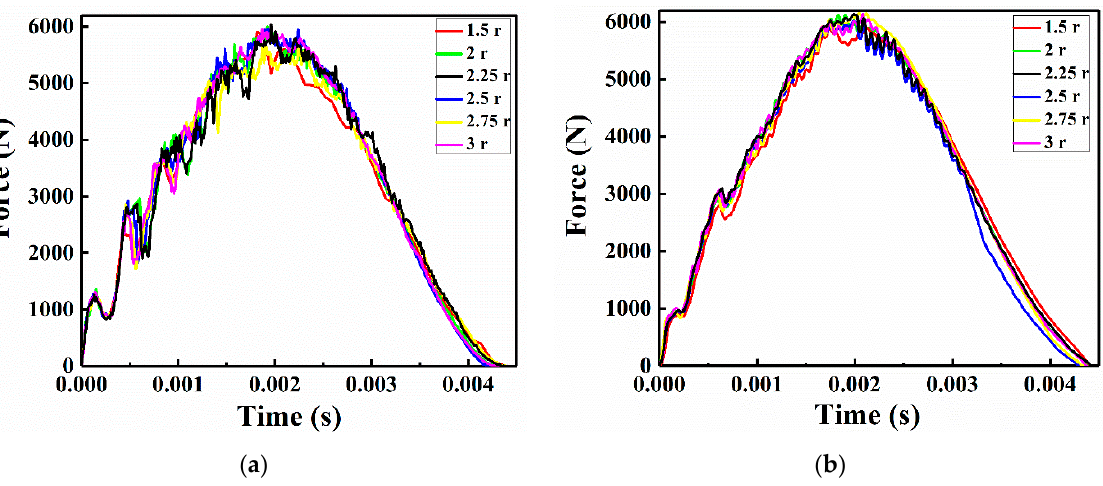
Figure 14. Impact force curves of the CFRP laminates repaired with patches of various sizes: ( a ) numerical and ( b ) exper- imental.